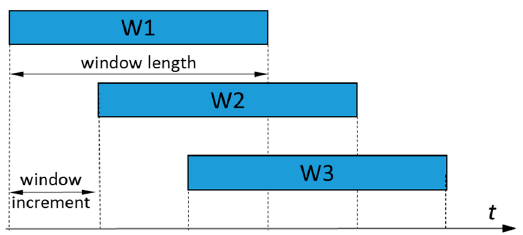
Figure 3. The moving windows used to calculate the features.